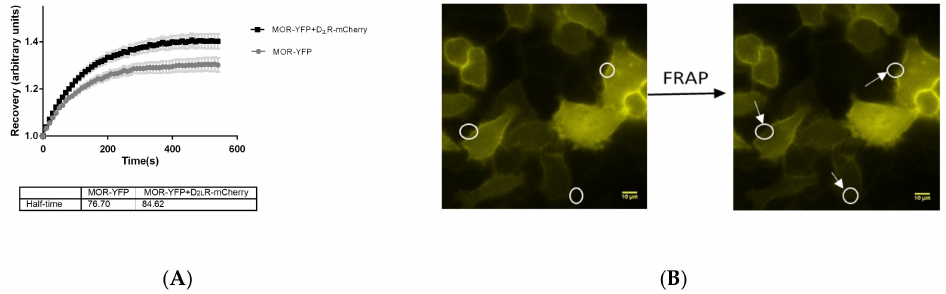
Figure 6. Analysis of interaction-mediated mobility change of MOR upon coexpression of D 2L R by FRAP analysis. HeLa cells transfected with pMOR-YFP with and without pD 2L R-mCherry were used for FRAP measurements, as described in the materials and methods section. ( A ) The plot depicts mean relative fluorescence intensity normalized to prebleach intensity as a function of time. The plot is an average for a population of approximately 50–60 cells from three–four independent experiments. The t 1 / 2 value refers to the time taken for half maximal recovery after photobleaching. ( B ) Representative images of a FRAP experiment. Several regions on the plasma membrane were photobleached and FRAP was monitored for 9 min with 10 s interval between every